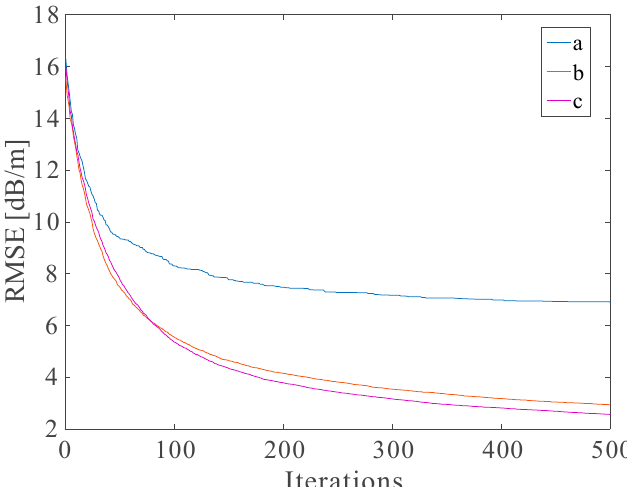
Figure 12. The average RMSE for these three algorithms according to the multiple tests; curve a is the average RMSE of the SGA; curve b is the average RMSE of the AMPGA; curve c is the average RMSE of the AMPGA with constraints.